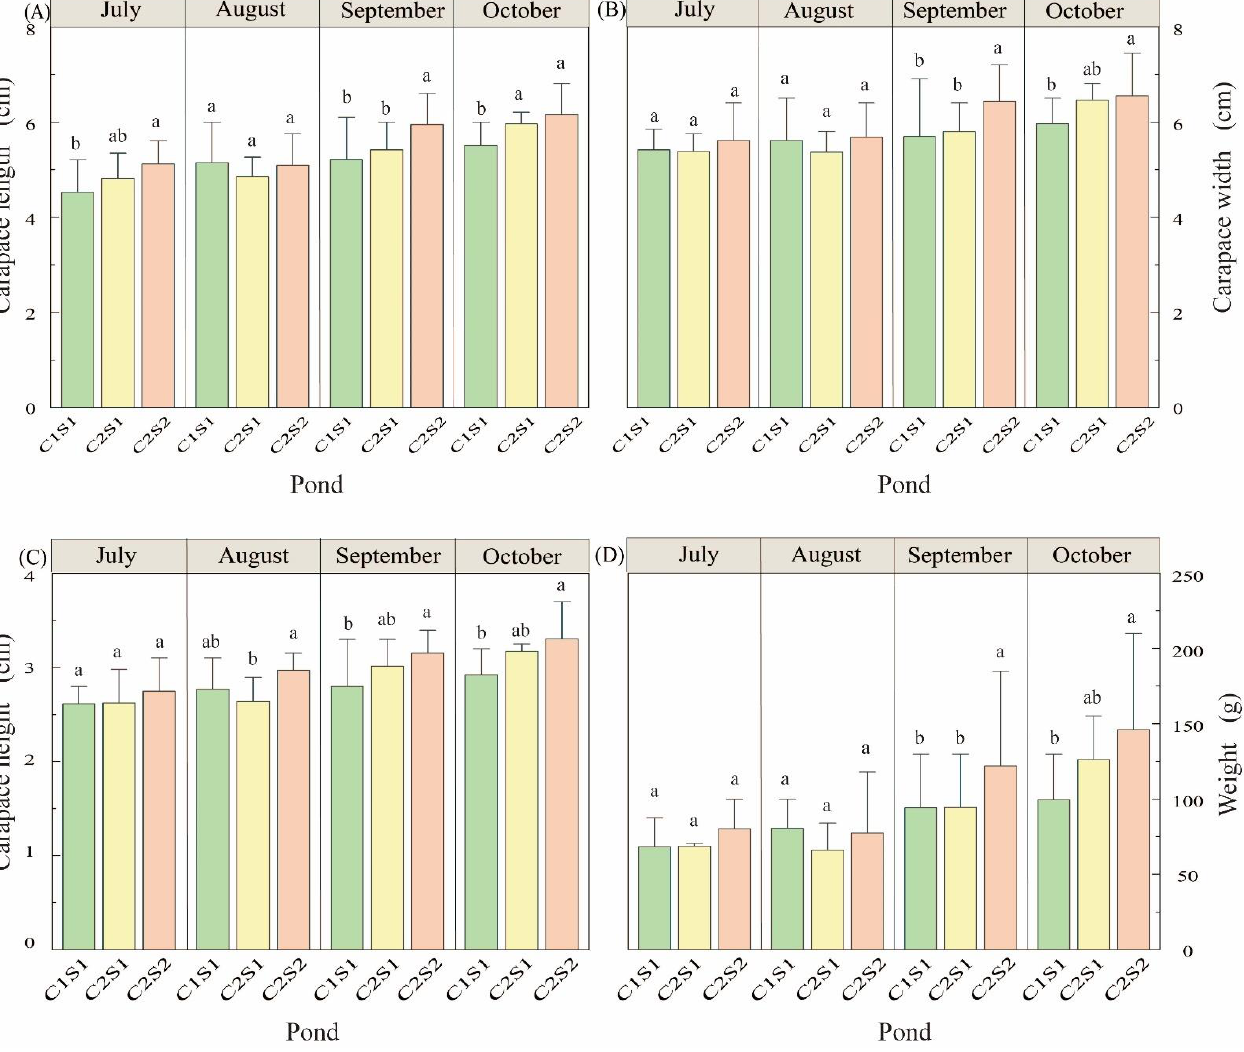
Figure 7. Increment dynamic of growth-related traits of E. sinensis in different ponds. ( A ) Carapace length; ( B ) Carapace width; ( C ) Carapace height; ( D ) Weight. Values with the same letter are not significantly different (LSD post hoc test).